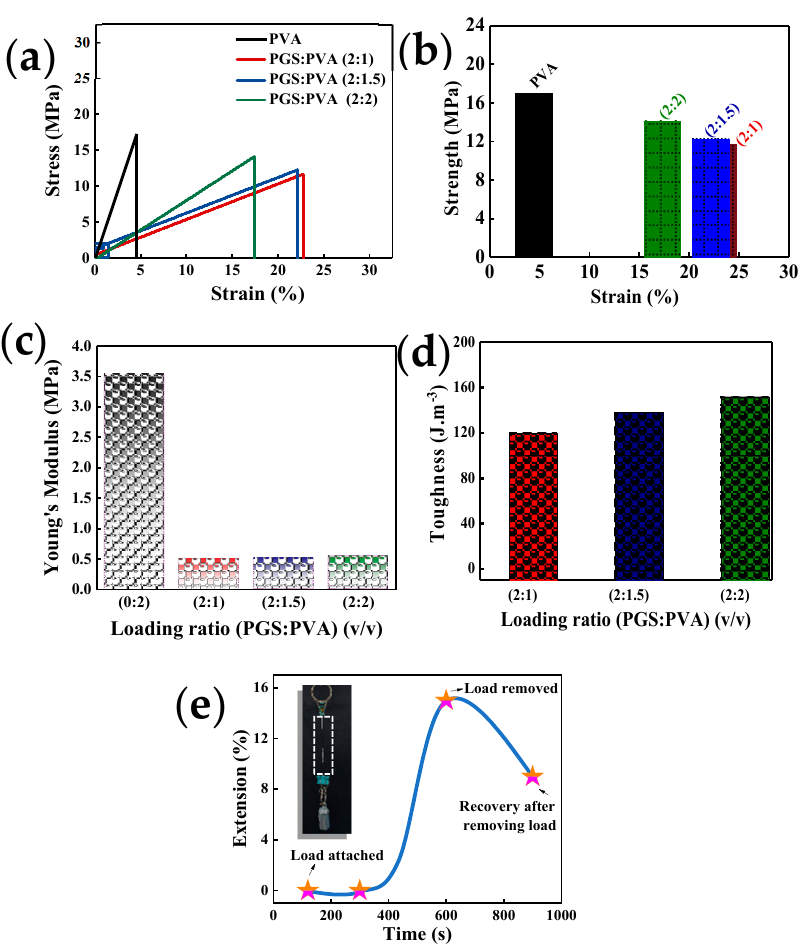
Figure 2. Mechanical properties of the biodegradable microfiber. ( a ) Stress-strain curves of the microfibers with varying loading ratios of PGS:PVA (2:1, 2:1.5, 2:2 ( v / v )). ( b ) Strength, ( c ) Young’s modulus, and ( d ) toughness of the biodegradable microfibers with various loading ratios of PGS:PVA (2:1, 2:1.5, 2:2 ( v / v )). ( e ) Creep test of a microfiber at a loading ratio of 2:1.5 under a hanging weight of 30 g at room temperature. The initial length is measured before addition of the hanging weight, and the final length change is in terms of extension% measured after removal of the weight.